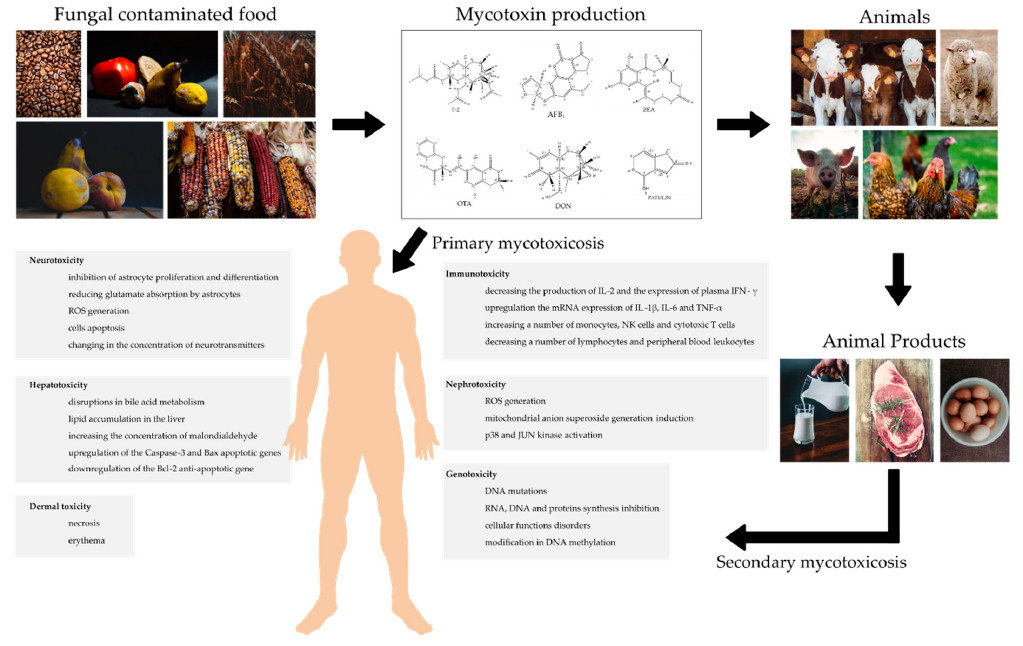
Figure 7. Mycotoxin mechanism of action and their impact on human organism.